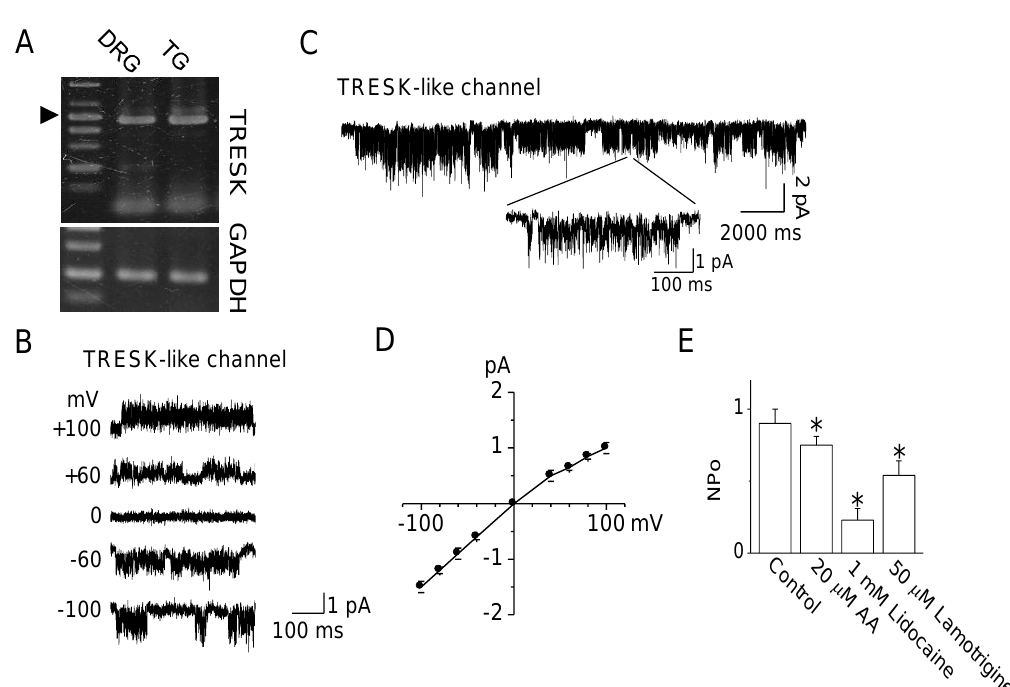
Figure 3. Functional expression of TRESK channels in rat TG neurons. ( A ) TRESK mRNA expression in TG neurons. DRG neurons were used as a positive control for TRESK expression. GAPDH was used as a loading control. An arrow head indicates 500-bp marker; ( B ) Single-channel recording of TRESK-like channel in TG neurons. Various pipette potentials (+100 to − 100 mV) were applied to TG neurons in symmetrical 150 mM K ⁺ solution; ( C ) Single-channel openings were recorded at 0 mV (pipette potential) in 5 mM K ⁺ solution; ( D ) Current – voltage relationship was drawn using amplitude recorded in various voltages; and ( E ) Effect of TRESK blockers on TRESK-like single-channel currents expressed in TG neurons. Data represent the mean ± SD of three repeated experiments. * p < 0.05 compared with the control.